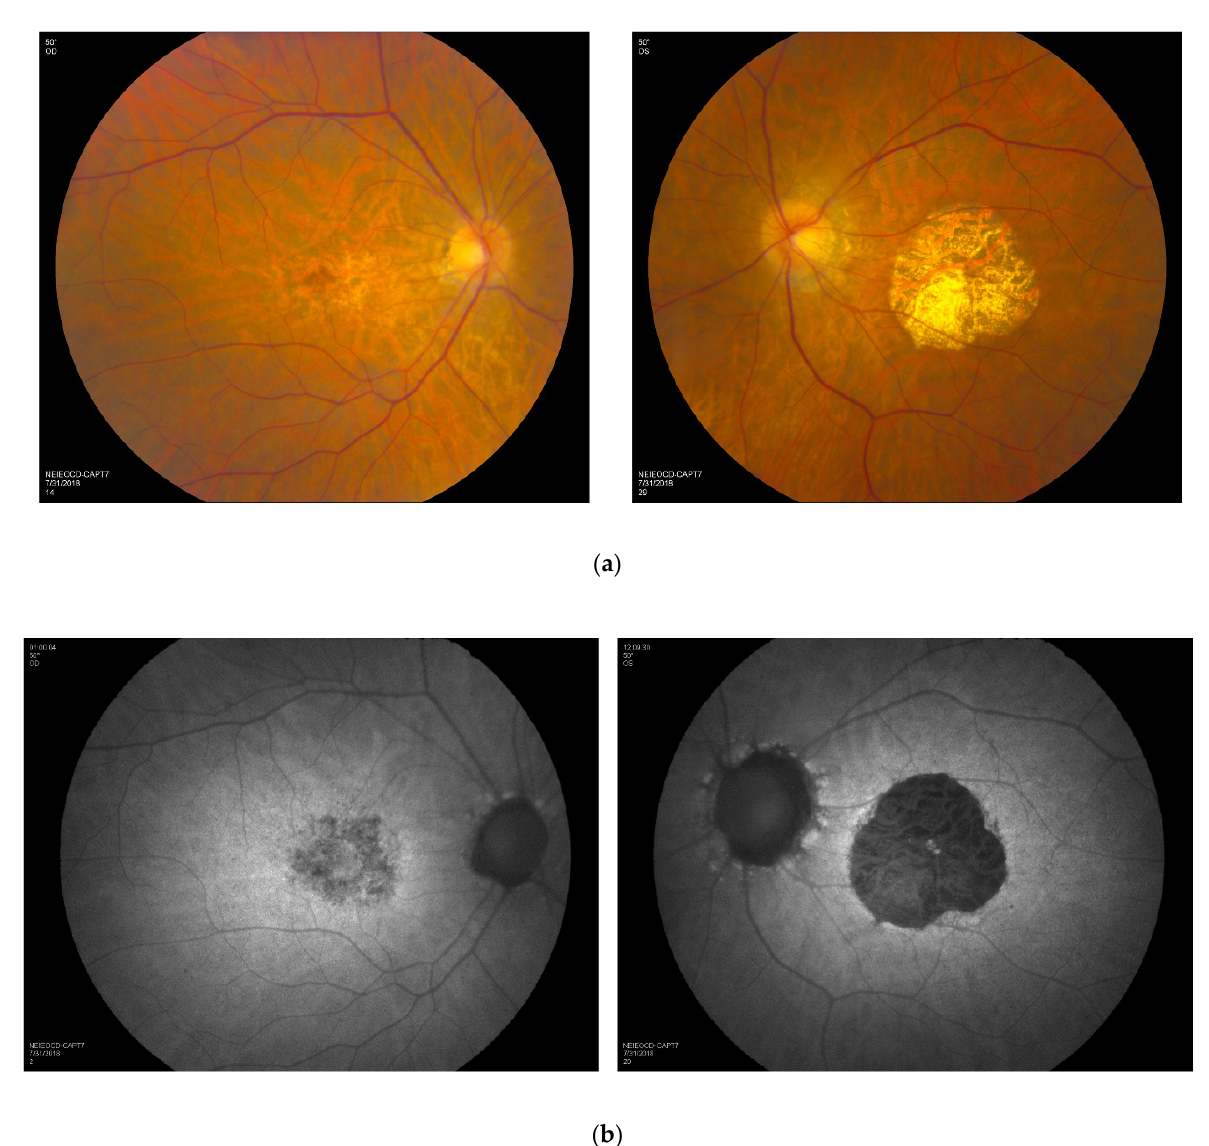
Figure 2. Asymmetry of macular involvement. Images document bilateral areas of macular atrophy with asymmetric disease indicating a greater degree of atrophy in the left eye (with questionably decreased autofluorescence in the right eye and distinctly decreased autofluorescence in the left eye). Color fundus photographs ( a ) and FAF images ( b ) of the right and left eyes of a patient with CRD. FAF, fundus autofluorescence; CRD, cone–rod dystrophy.